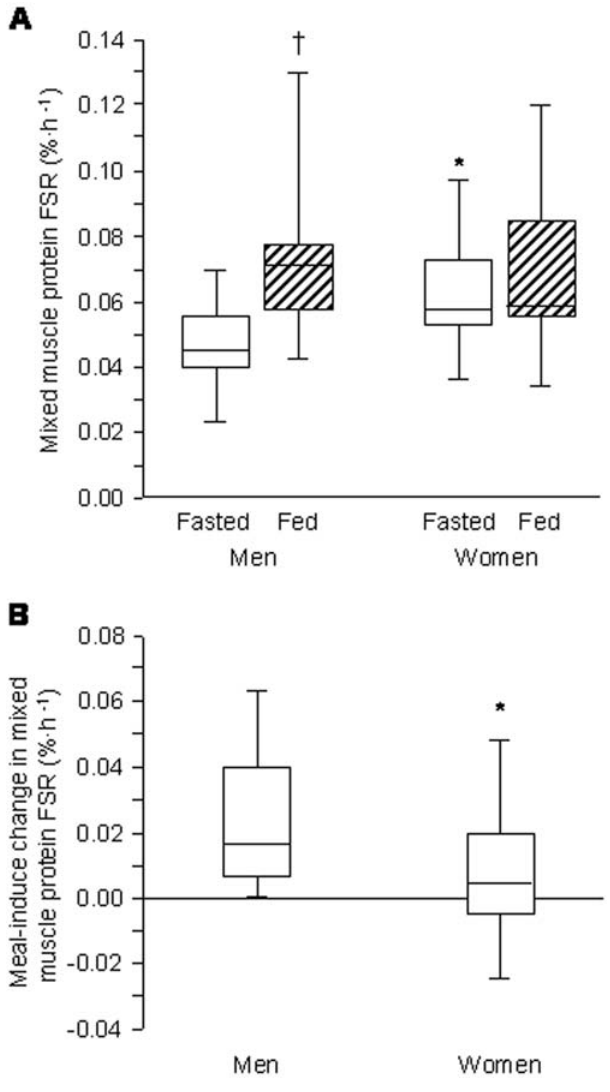
Figure 1. Muscle protein synthesis rate in men and women. Panels A and B show the mixed skeletal muscle protein fractional synthesis rate (FSR) during basal, post-absorptive conditions (fasted) and liquid mixed meal consumption (fed) in men and women ( A ) and the meal-induced change in the FSR in men and women ( B ). Graphs show the median (central horizontal line), 25 th and 75 th percentiles (box), and minimum and maximum values (vertical lines). * Value significantly different from corresponding value in men. { Value significantly different from corresponding value during basal, postab- sorptive (fasted)